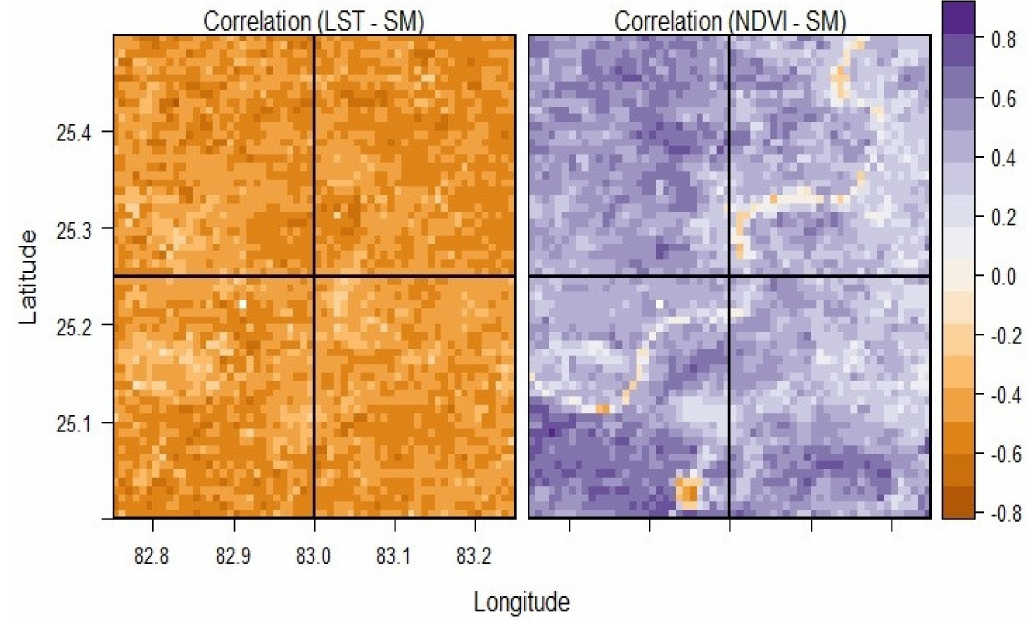
Figure 3. Correlation plot of LST and AMSR-2 soil moisture of study area ( right ). Correlation plot of NDVI and AMSR-2 soil moisture of the study area ( left ). The four AMSR-2 pixels are marked in each figure with black